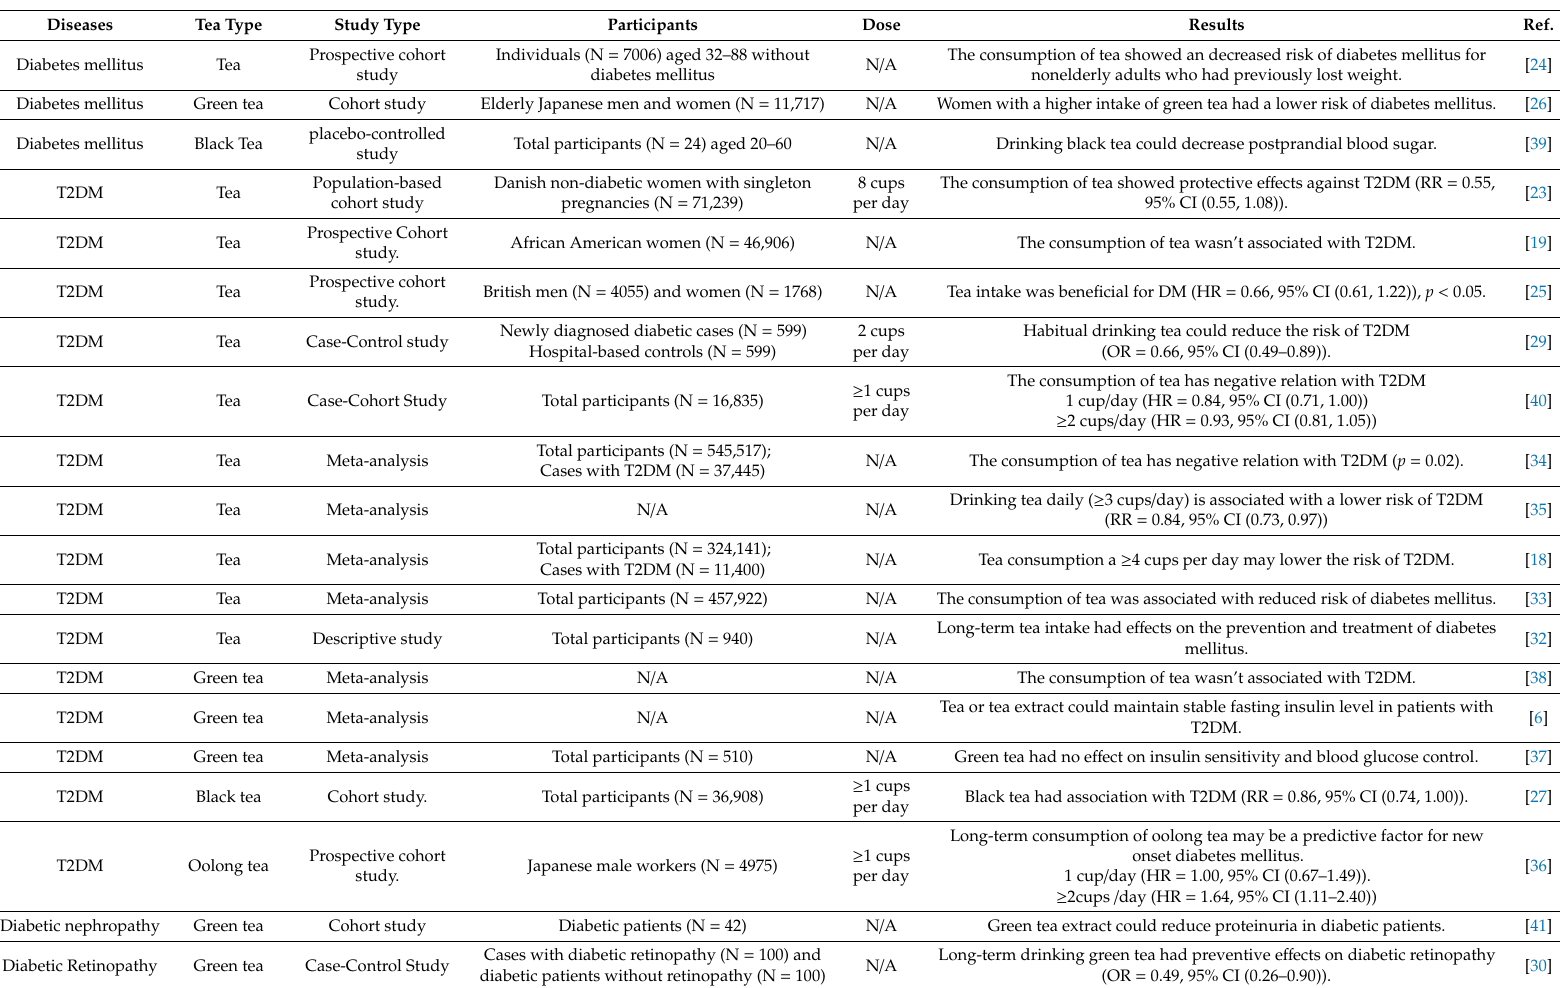
Table 1. The relationship of tea consumption and diabetes mellitus by epidemiological studies.